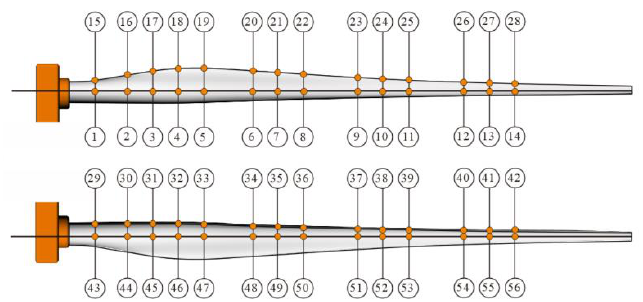
Figure 2. The strain gauges arrangement in the turbine blade.